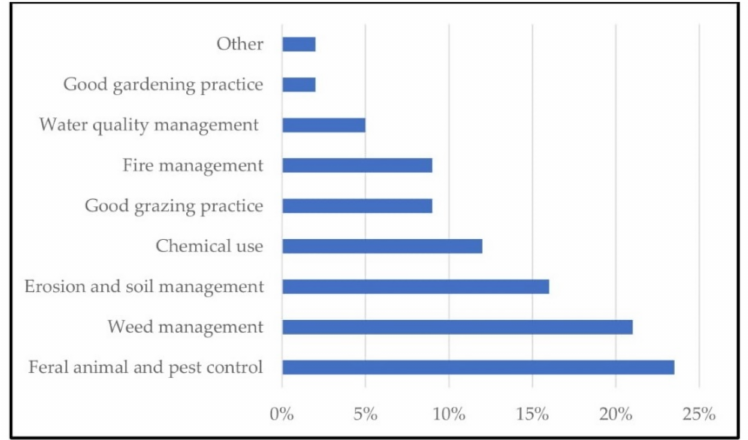
Figure 6. Knowledge limitations identified by